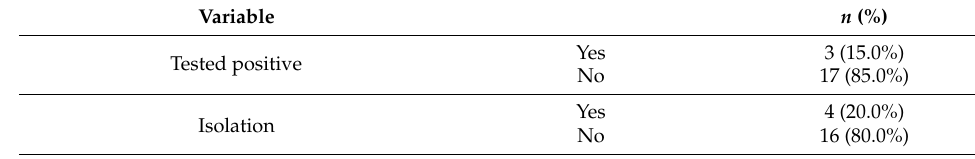
Table 4. Descriptive statistics of COVID-19-related concerns.